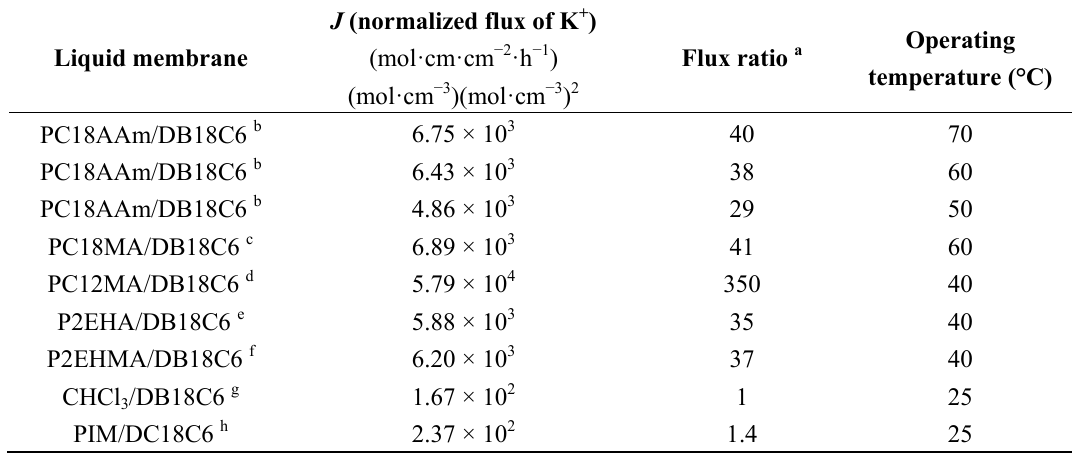
Table 1. Comparison of normalized K + flux values for various